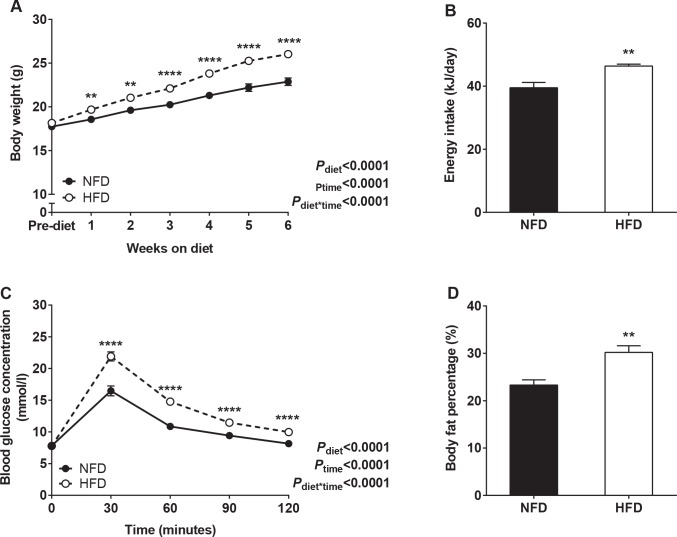
Maternal parameters prior to pregnancy.(A) Body weight and (B) energy intake across the 6 week pre-pregnancy period in NFD and HFD mice. (C) Glucose tolerance and (D) body fat percentage in NFD and HFD mice after 6 weeks on diet. **P<0.01, ****P<0.0001.